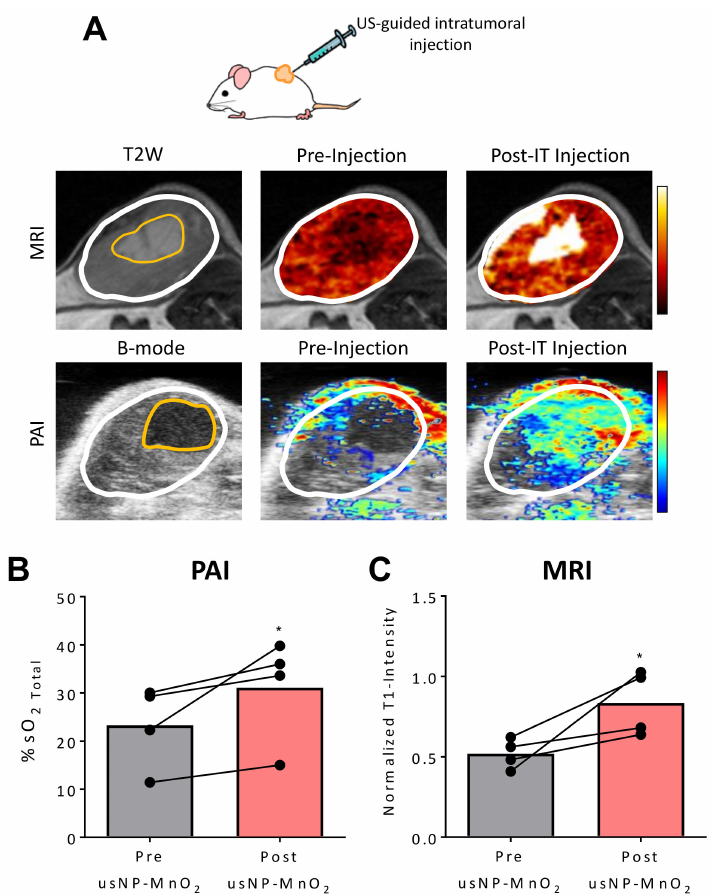
Figure 5. Ultrasound (US)-guided direct delivery of nanoparticles for localized modulation of hypoxia in the HNSCC microenvironment. ( A ) Panel of MR and photoacoustic (PA) images showing an HNSCC PDX before and after intratumoral (i.t.) injection of usNP-MnO 2 . US-enabled directed delivery of nanoparticles to avascular / hypoxic region (outlined in yellow) within the tumor (outlined in white). Graphs showing %sO 2 ( B ) and normalized T1W signal intensity ( C ) before and after injection of usNP-MnO 2 , * p <